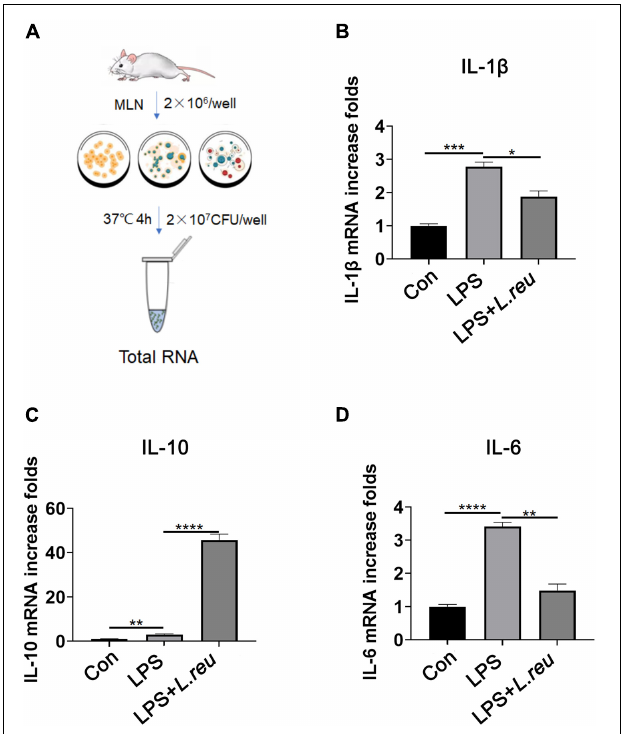
FIGURE 5 | Effect of Lactobacillus reuteri on the expression of IL-1 β , IL-10, and IL-6 in mesenteric lymph node cells stimulated by LPS in vitro . (A) Schematic diagram of experiment setup. In the presence or absence of L. reuteri , MLN cells were stimulated with LPS alone for 4 h. Cells were collected for qPCR analysis. (B–D) mRNA expression of IL-1 β , IL-10, and IL-6 in MLN cells. Data are expressed as the mean ± SEM. p < 0.05, ** p < 0.01, *** p < 0.001, **** P < 0.0001. Con, control; L. reu , Lactobacillus reuteri